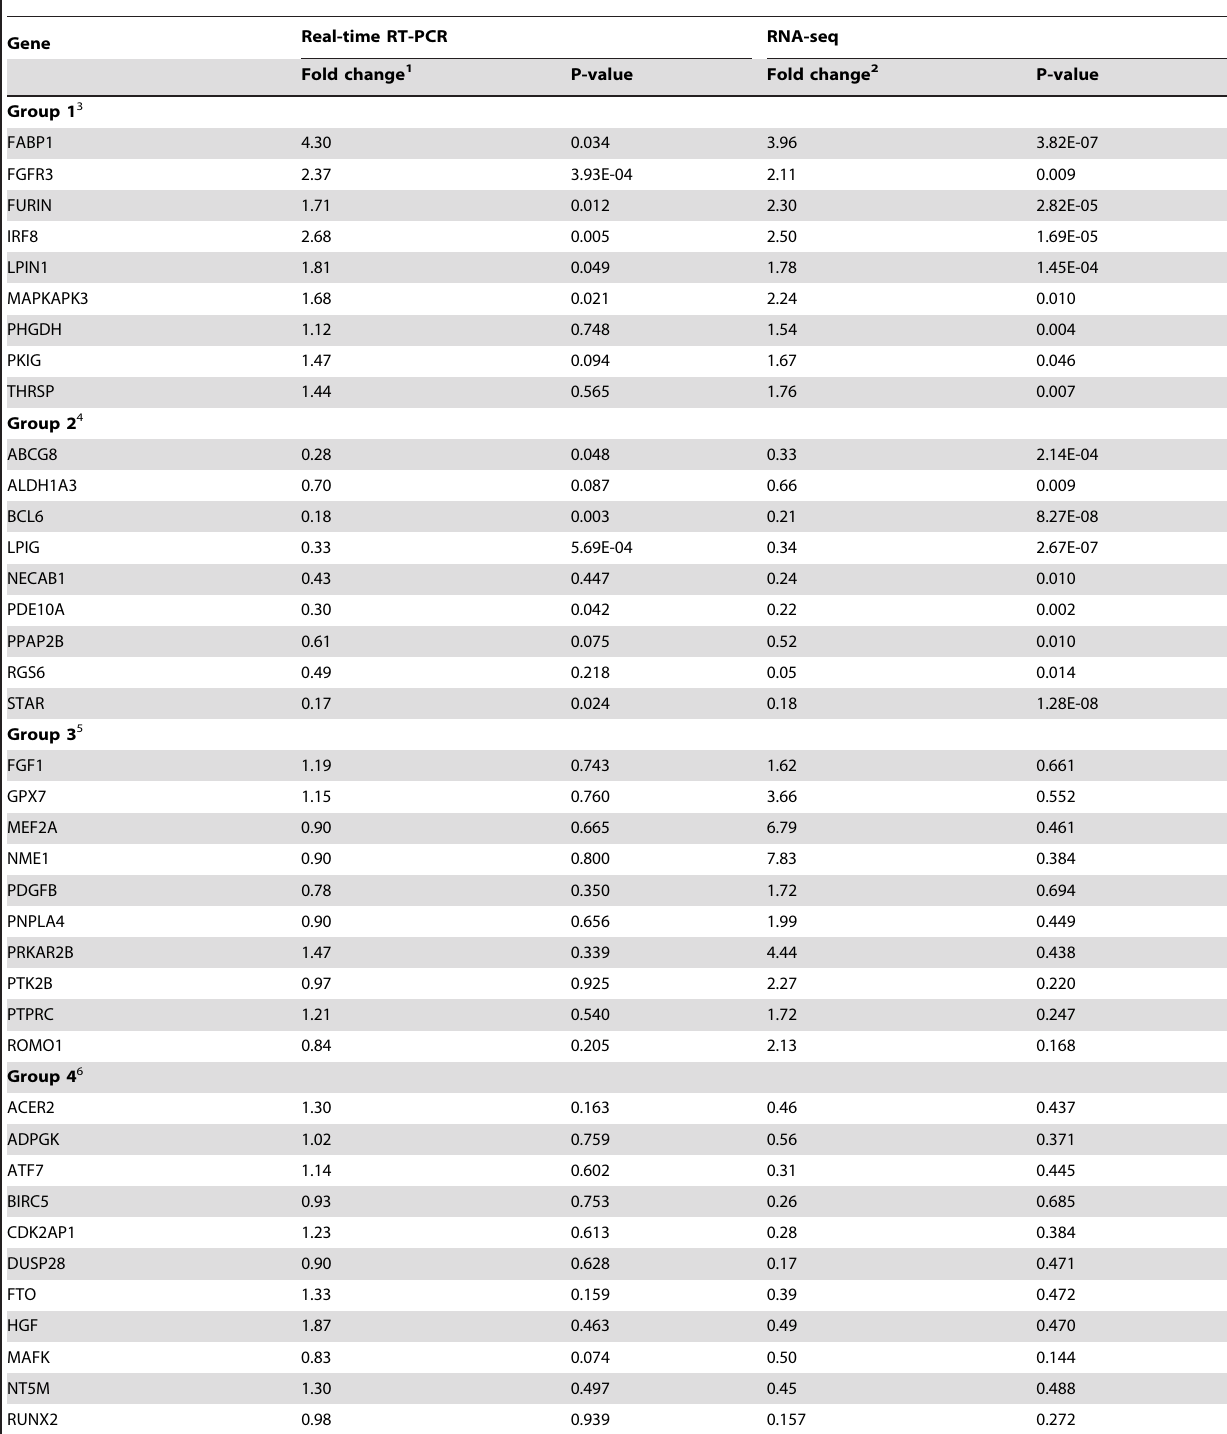
Table 3. Real time RT-PCR validation of gene expression levels revealed by